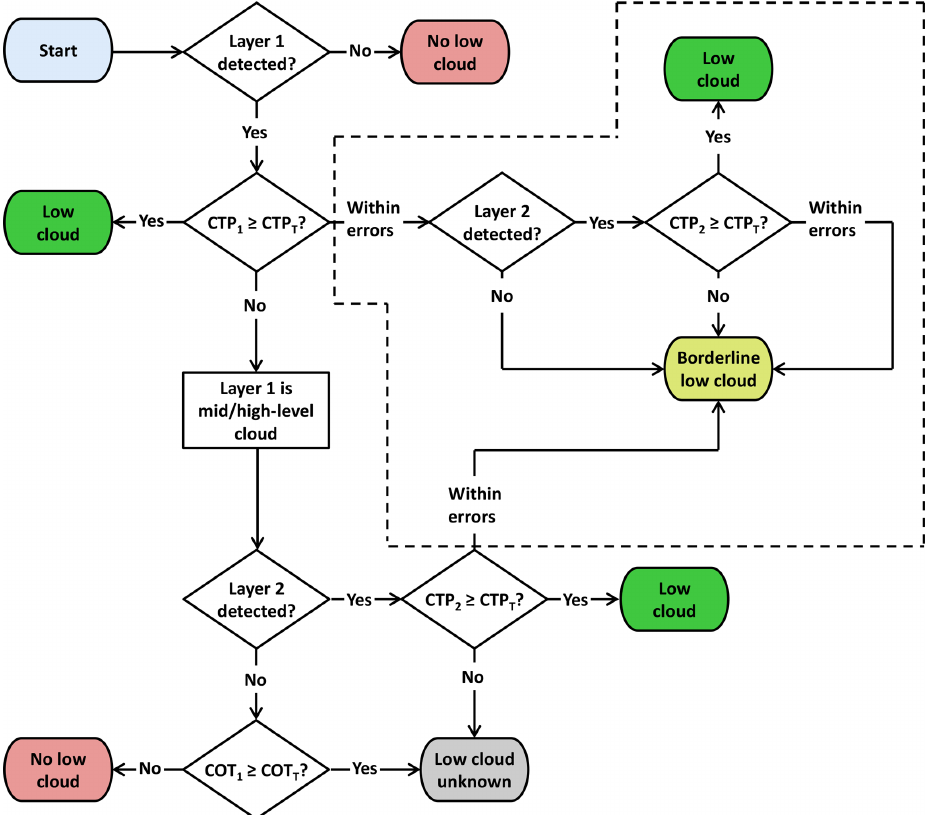
Figure A1. Schematic describing the derivation of the LLC flag from SEVIRI OCA data. We used values of CTP T = 680hPa and log 10 ( COT T ) = 0. The dashed lines separate off the section of the scheme that is only necessary where the per-pixel uncertainty is con- sidered.